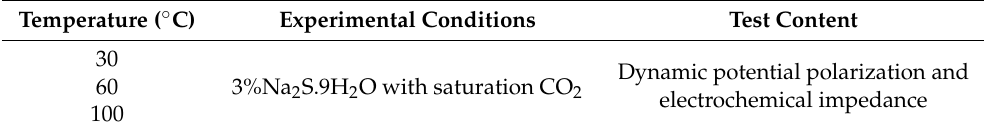
Table 5. Electrochemical experimental protocol.